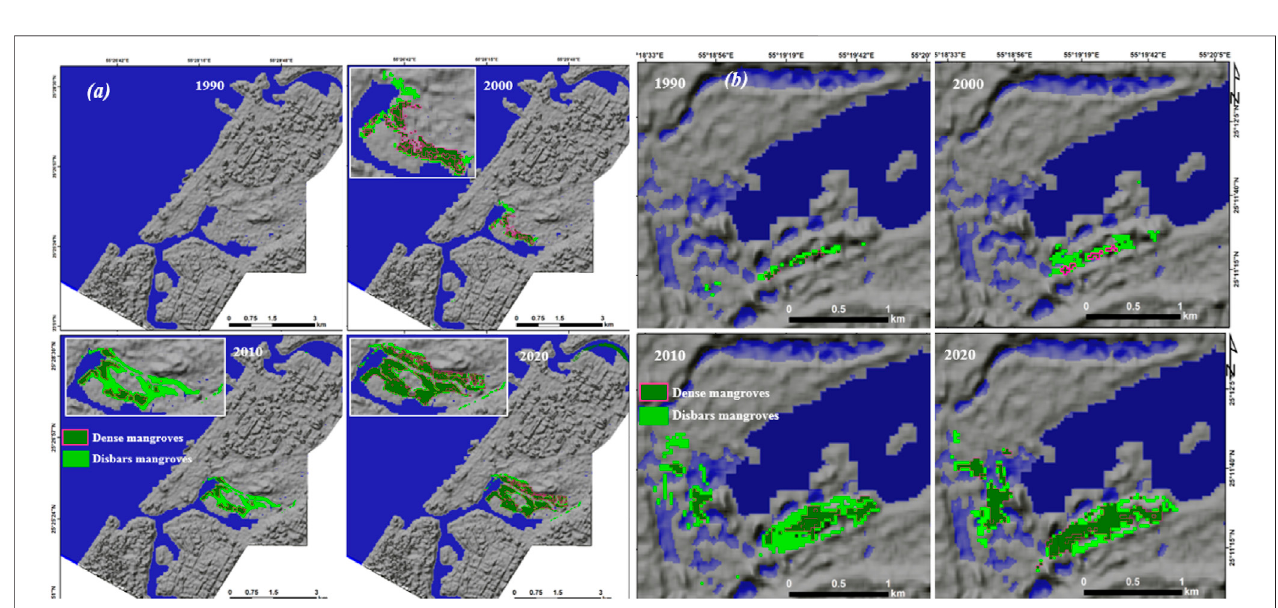
FIGURE7| Spatiotemporalvariationofmangrove forests onthecoastalareaofAjman – AlHamriyacreeks (A) and RasAlKhorofDubai (B) fortheyearsfrom1990 to 2020.